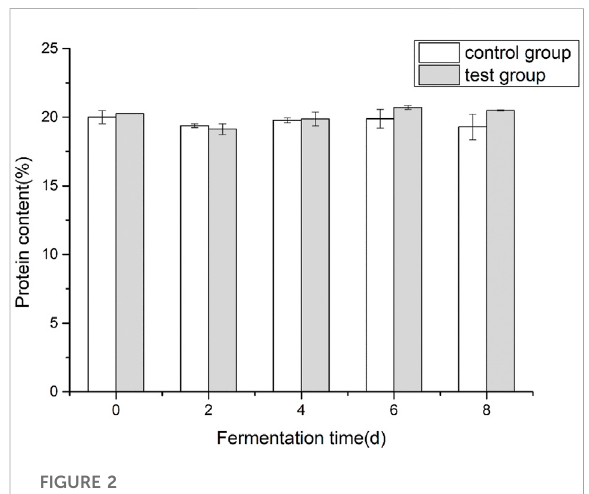
FIGURE 2 Effect of fermentation on the protein contents of cigar tobacco